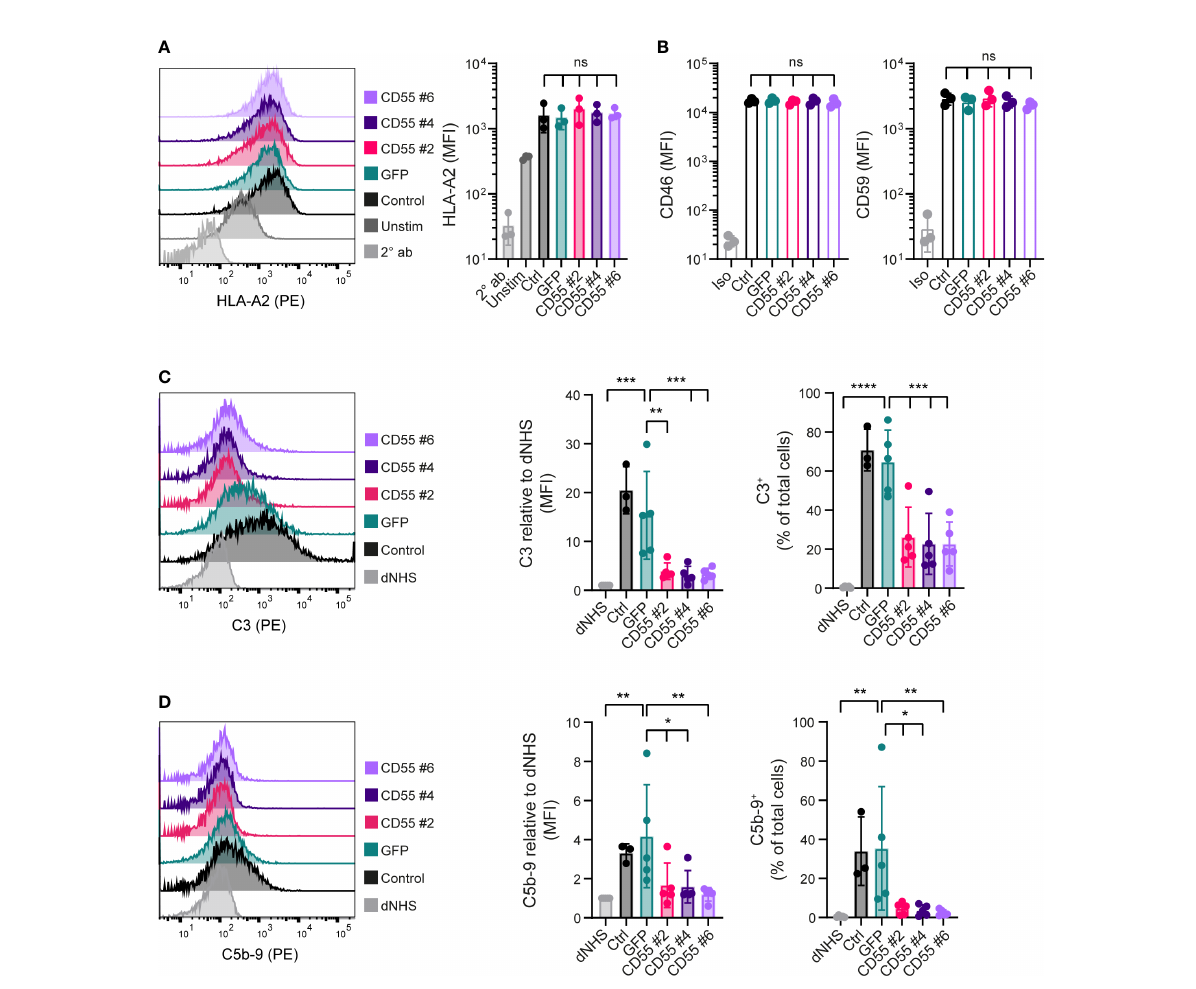
FIGURE 3 CD55 overexpression in iPSCs decreases complement deposition. (A) Cell surface opsonization by anti-HLA-A2 in unstimulated (Unstim) and IFN- g stimulated (Ctrl, GFP, CD55 #2, 4 and 6) iPSCs measured by fl ow cytometry. A representative histogram is shown and results are presented as mean fl uorescence intensity (MFI) in three independent experiments (n=3). Staining with only PE-conjugated secondary antibody (2° ab) is shown in light grey. (B) CD46 and CD59 protein surface expression on iPSCs measured by fl ow cytometry (n=3). Staining with isotype (Iso) is shown in light grey. ( C, D ) C3 and C5b-9 deposition on iPSCs incubated with normal human serum (NHS) measured by fl ow cytometry. Incubation with heat-inactivated NHS (dNHS) was used as negative control and is shown in light grey. Results are presented as relative mean fl uorescence intensity (MFI) and C3 + or C5b-9 + proportion. A representative histogram is shown (n=3 for control, n=5 for others). Error bars show standard deviation and signi fi cance (*p < 0.05; **p < 0.01; ***p < 0.001; ****p < 0.0001) was evaluated using one-way ANOVA comparing each sample to iPSC-GFP with Dunnett correction for multiple comparisons. ns, non signi fi